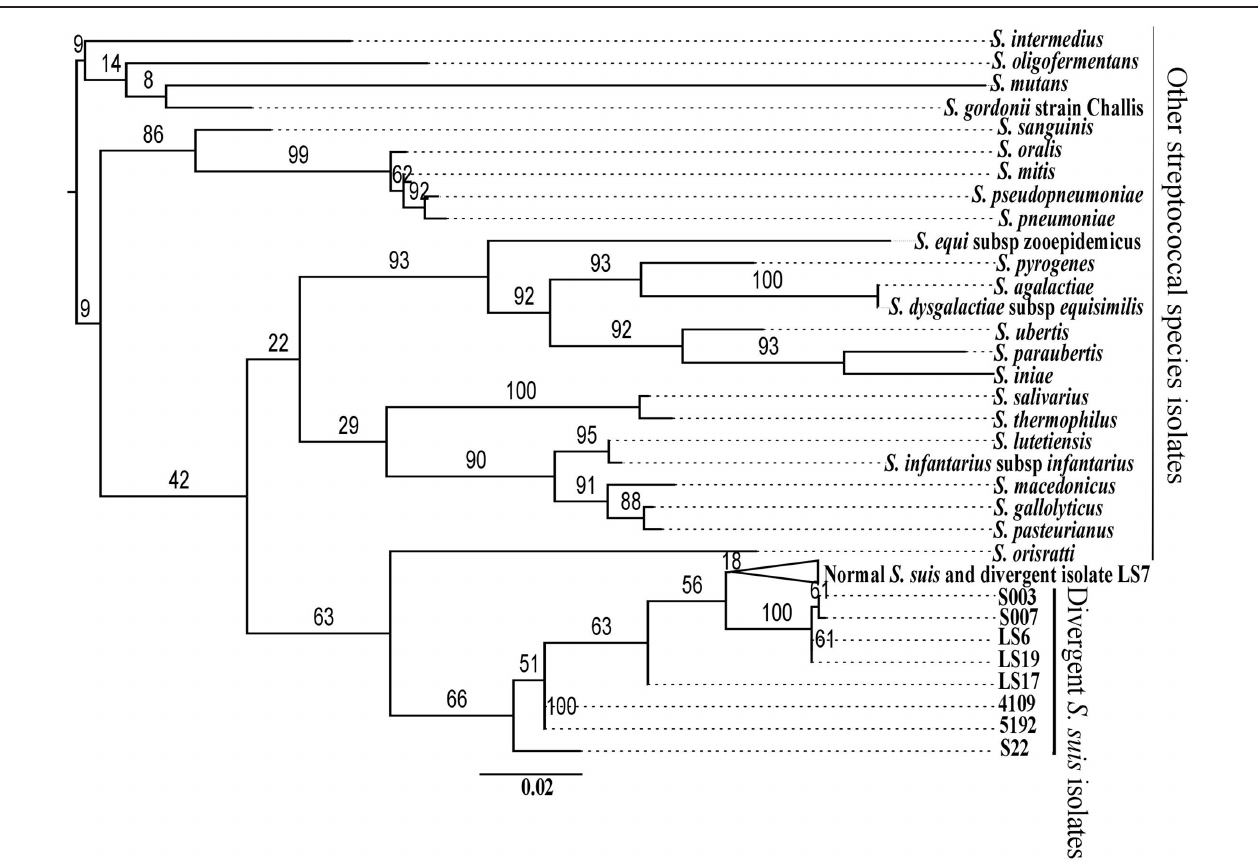
FIGURE 2 | Maximum likelihood phylogenetic reconstruction of the 16S rRNA gene sequences of the divergent isolates with those from normal S. suis and representatives of the other 24 streptococcal species. The branches with the 73 normal S. suis isolates and the divergent isolate LS7 have been